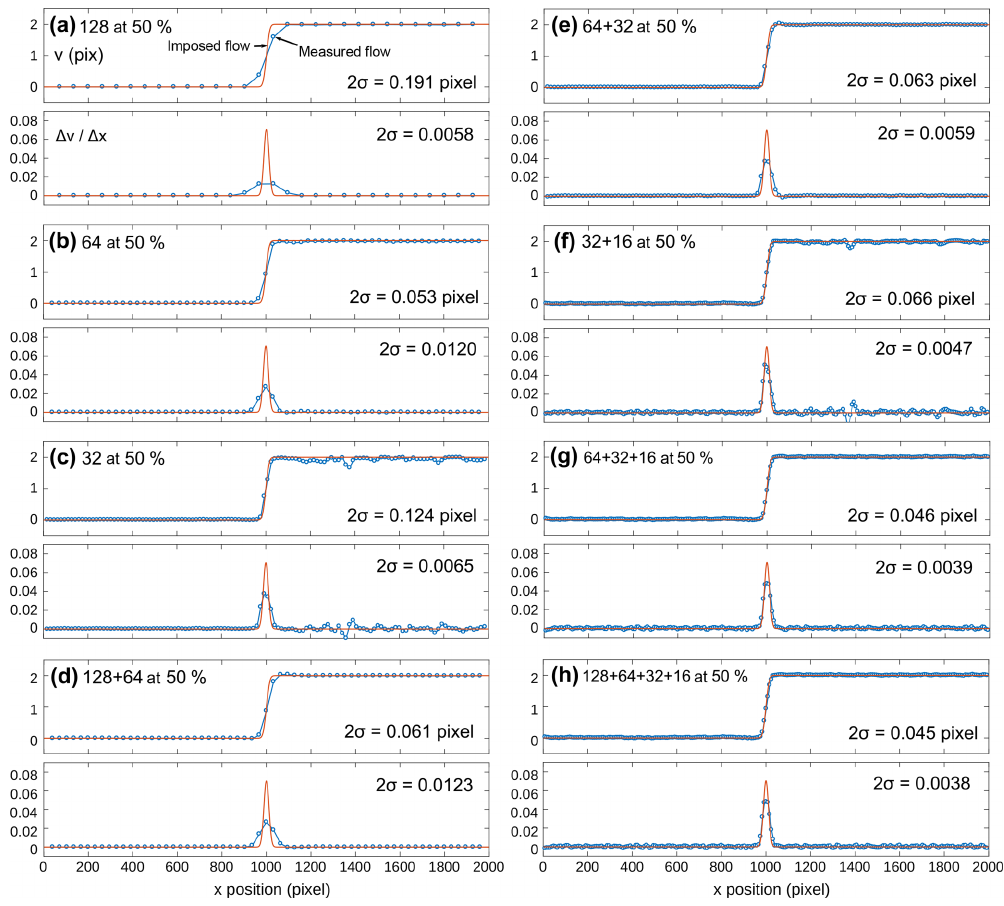
Figure 4. PIV results for the narrow static shear zone synthetic test. Shear zone width is 64 pixels; y -axis velocity component of the right-hand side is 2 pixels per frame. (a) Single-pass interrogation area width: w = 128 pixels; (b) single pass with w = 64 pixels; (c) w = 32